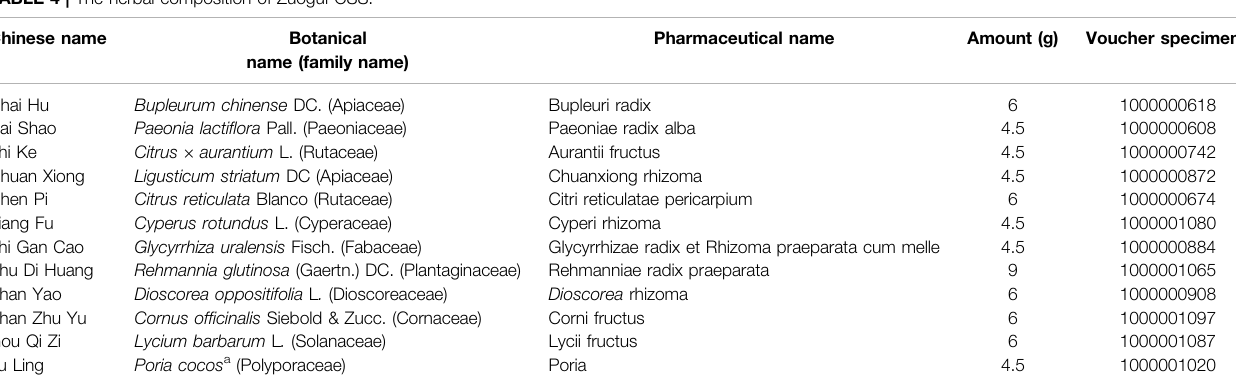
TABLE 4 | The herbal composition of